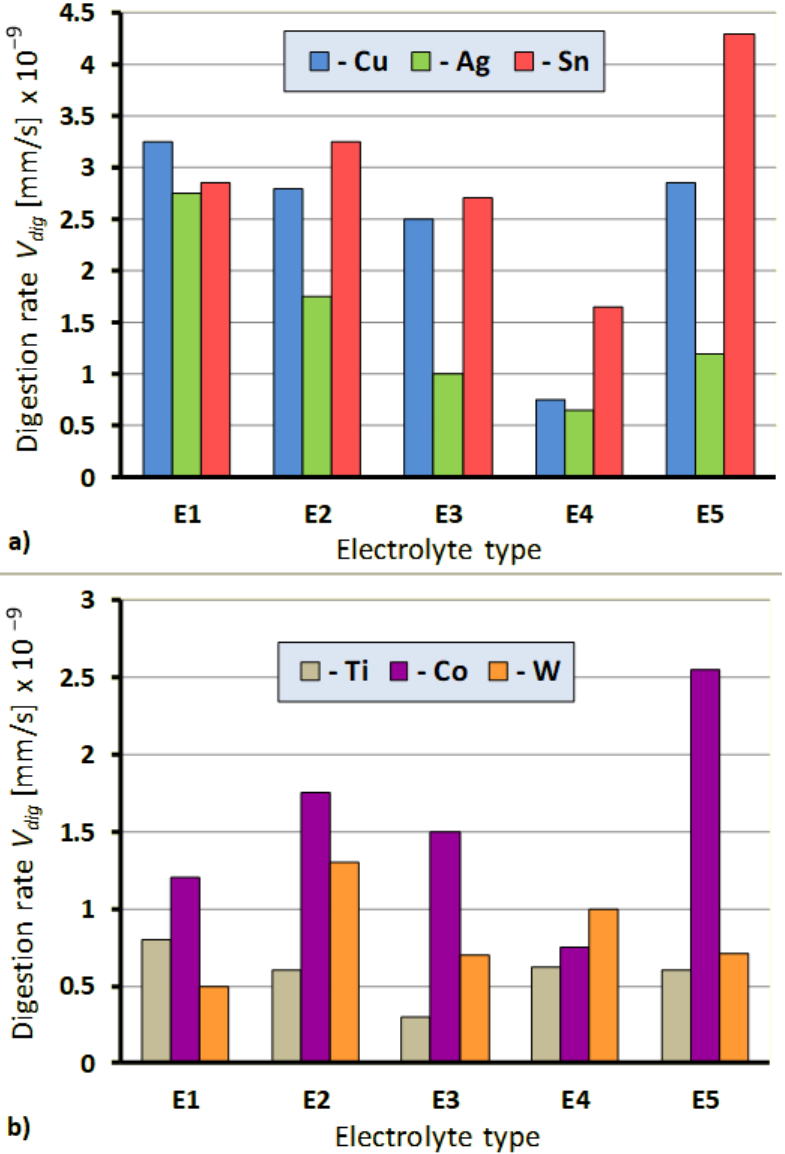
Figure 6. The effect of electrolyte composition (Table 2) on the digestion rate of the grinding wheel components: ( a ) Grinding wheel metals bond; ( b ) Metals in products of loading in the cutting surface of grinding wheel (CSGW).